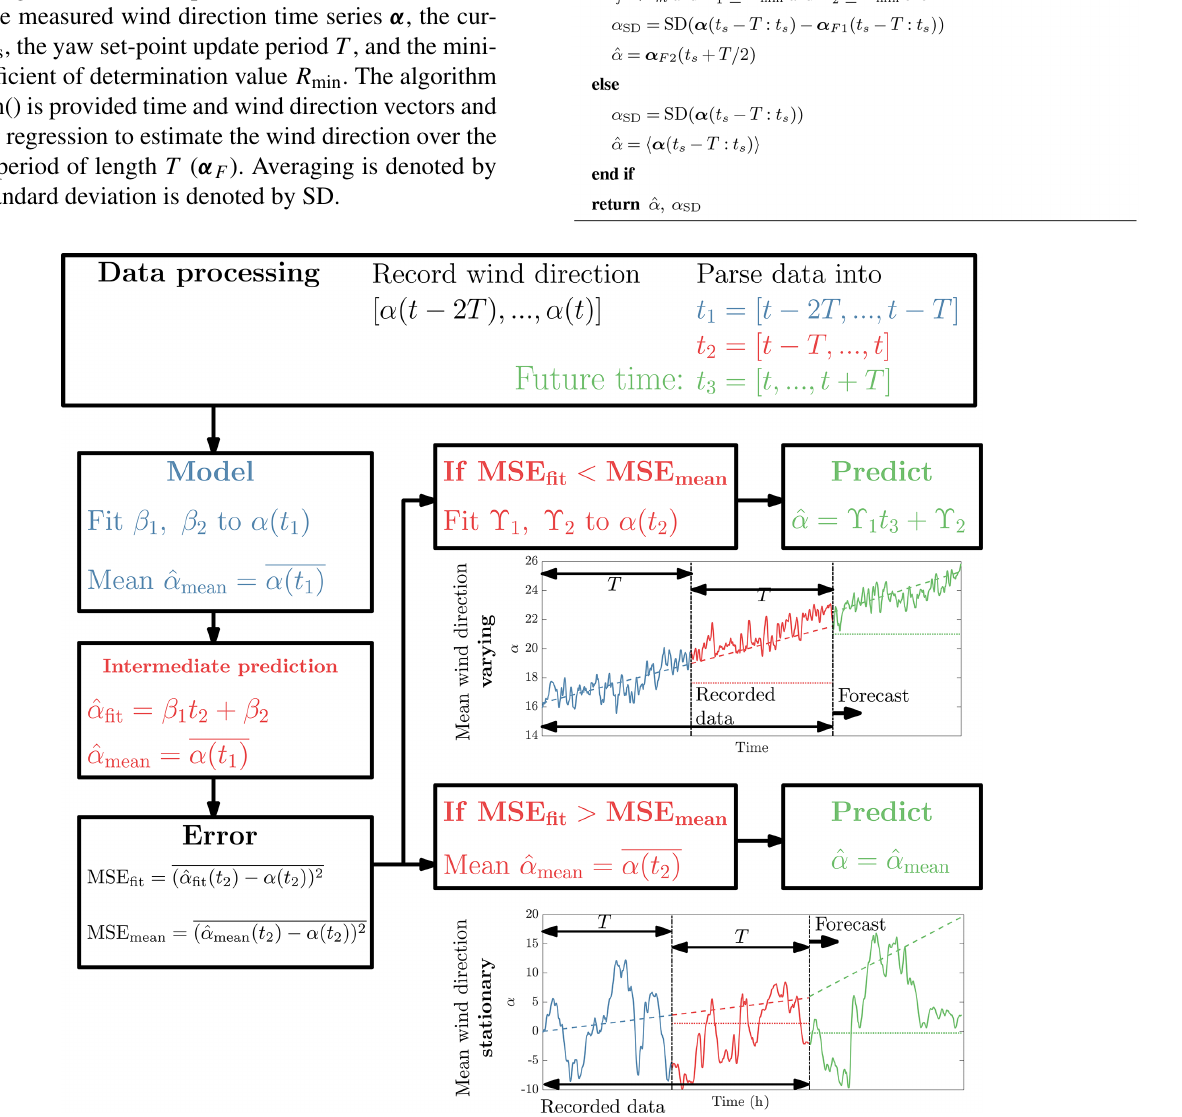
Figure A1. Wind direction estimation algorithm DirectionEstimation. Dashed lines are wind direction predictions using regression, and dotted lines are predictions using the mean